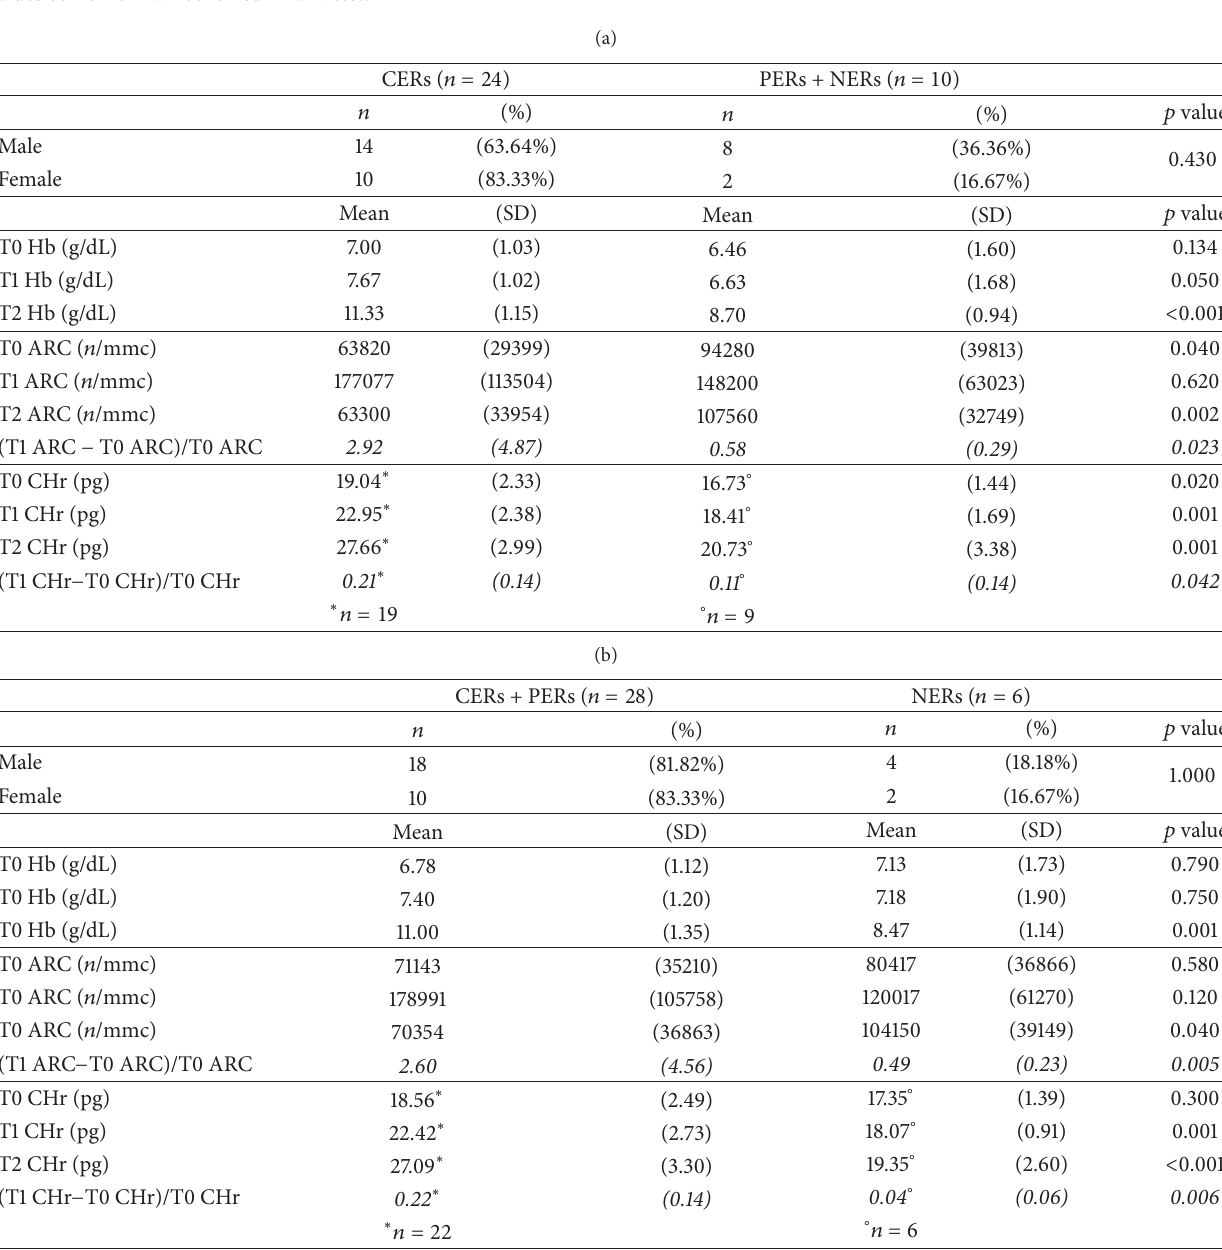
Table 3: Descriptive characteristics of patients, divided into CERs = complete early responders (i.e., normal Hb value at day +30 for therapy onset), PERs = partial early responders (Hb value at day +30 at least 50% higher than the original one), and NERs = not early responders. 𝑝 values come from Wilcoxon sum rank